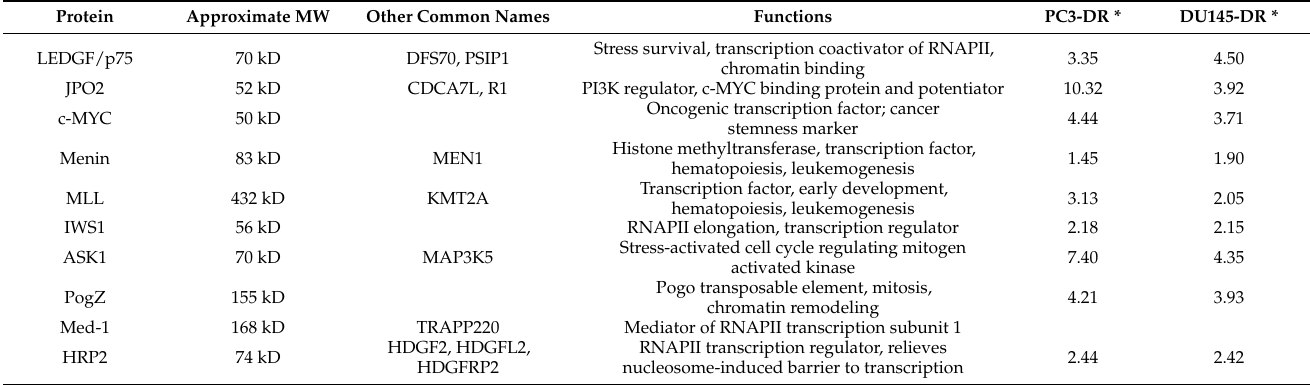
Table 1. Nomenclature, functions, and average fold induction of LEDGF/p75 interactome proteins in docetaxel-resistant PC3-DR and DU145-DR cells relative to their sensitive